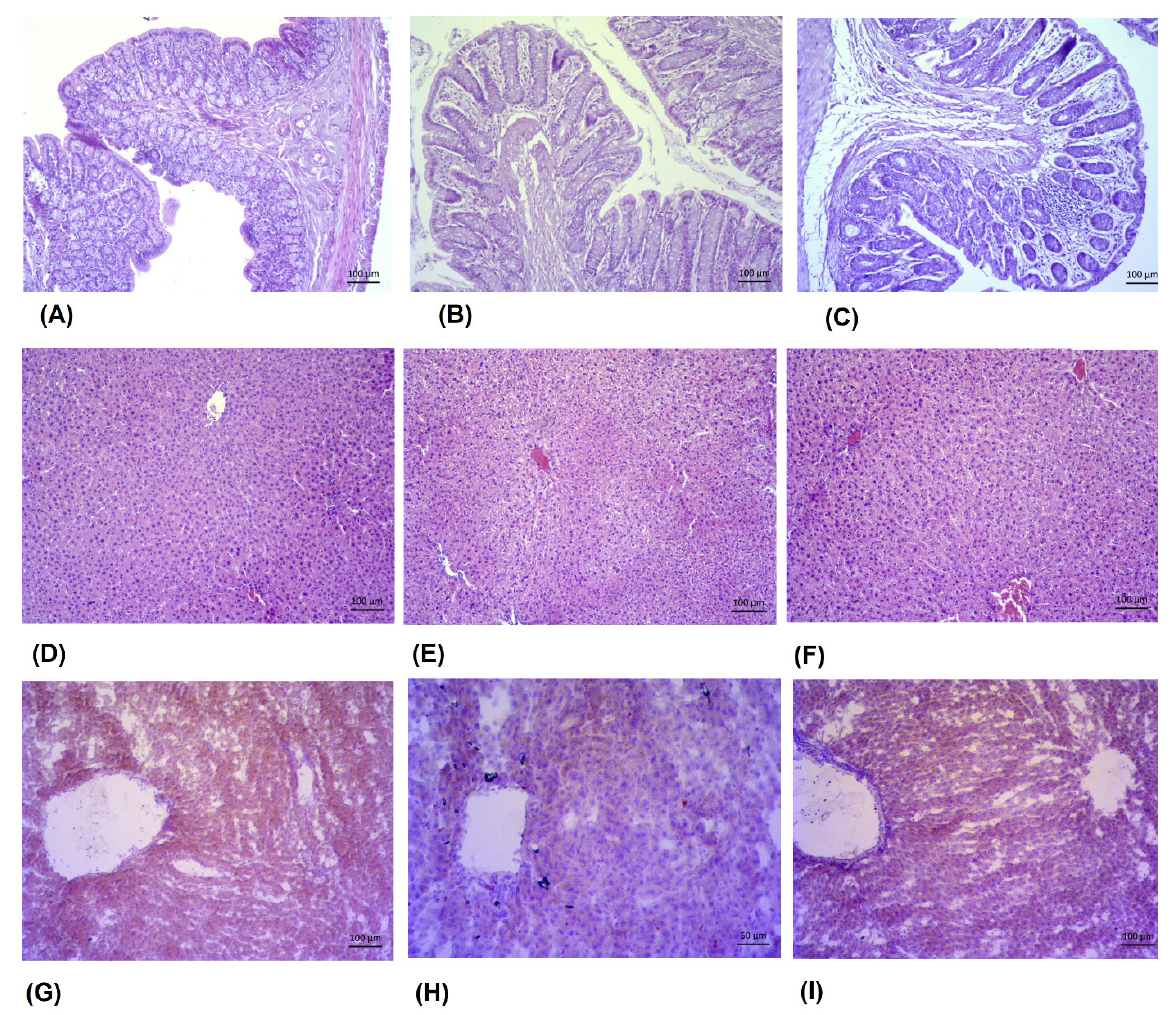
Figure 11. Histology of the gut (ileum) and liver of experimental animals. Hematoxylin–eosin (H&E) stain: ( A ) Control, ileum (H&E, 10×); ( B ) Laurel oil, ileum (H&E, 10×); ( C ) Myrtle oil, ileum (H&E, 10×); ( D ) Control, liver (H&E, 10×); ( E ) Laurel oil, liver (H&E, 10×); ( F ) Myrtle oil, liver (H&E, 10×). Lipid staining with oil red O stain and hematoxylin counterstain: ( G ) Control, liver (oil red O, 20×); ( H ) Laurel oil, liver (oil red O, 20×); ( I ) Myrtle oil, liver (oil red O, 20×).